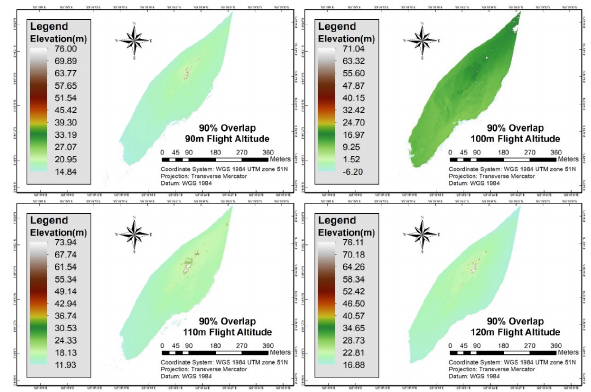
Figure 9 . Digital Terrain Models (DTMs) at 75% overlap generated using the acquired UAS data and disabled interpol ated setting. The white areas implied “no data” pixel s.